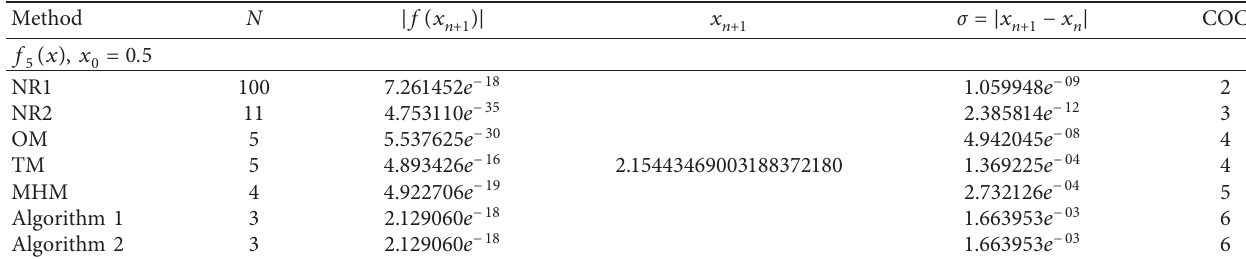
Table 5: Comparison of various iterative